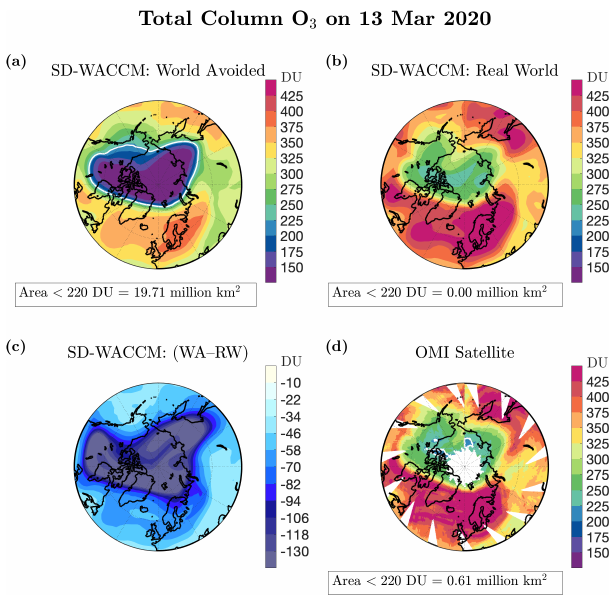
Figure 1. Total column ozone poleward of 30 ◦ N for 13 March 2020. Panel (a) shows the WA SD-WACCM run, panel (b) shows the RW run, and panel (c) shows the difference between them. Panel (d) shows the total column ozone Level 3 product from the OMI satellite. All levels are in Dobson units. Note the different scale in the lower left color bar. The 220DU contour is outlined in